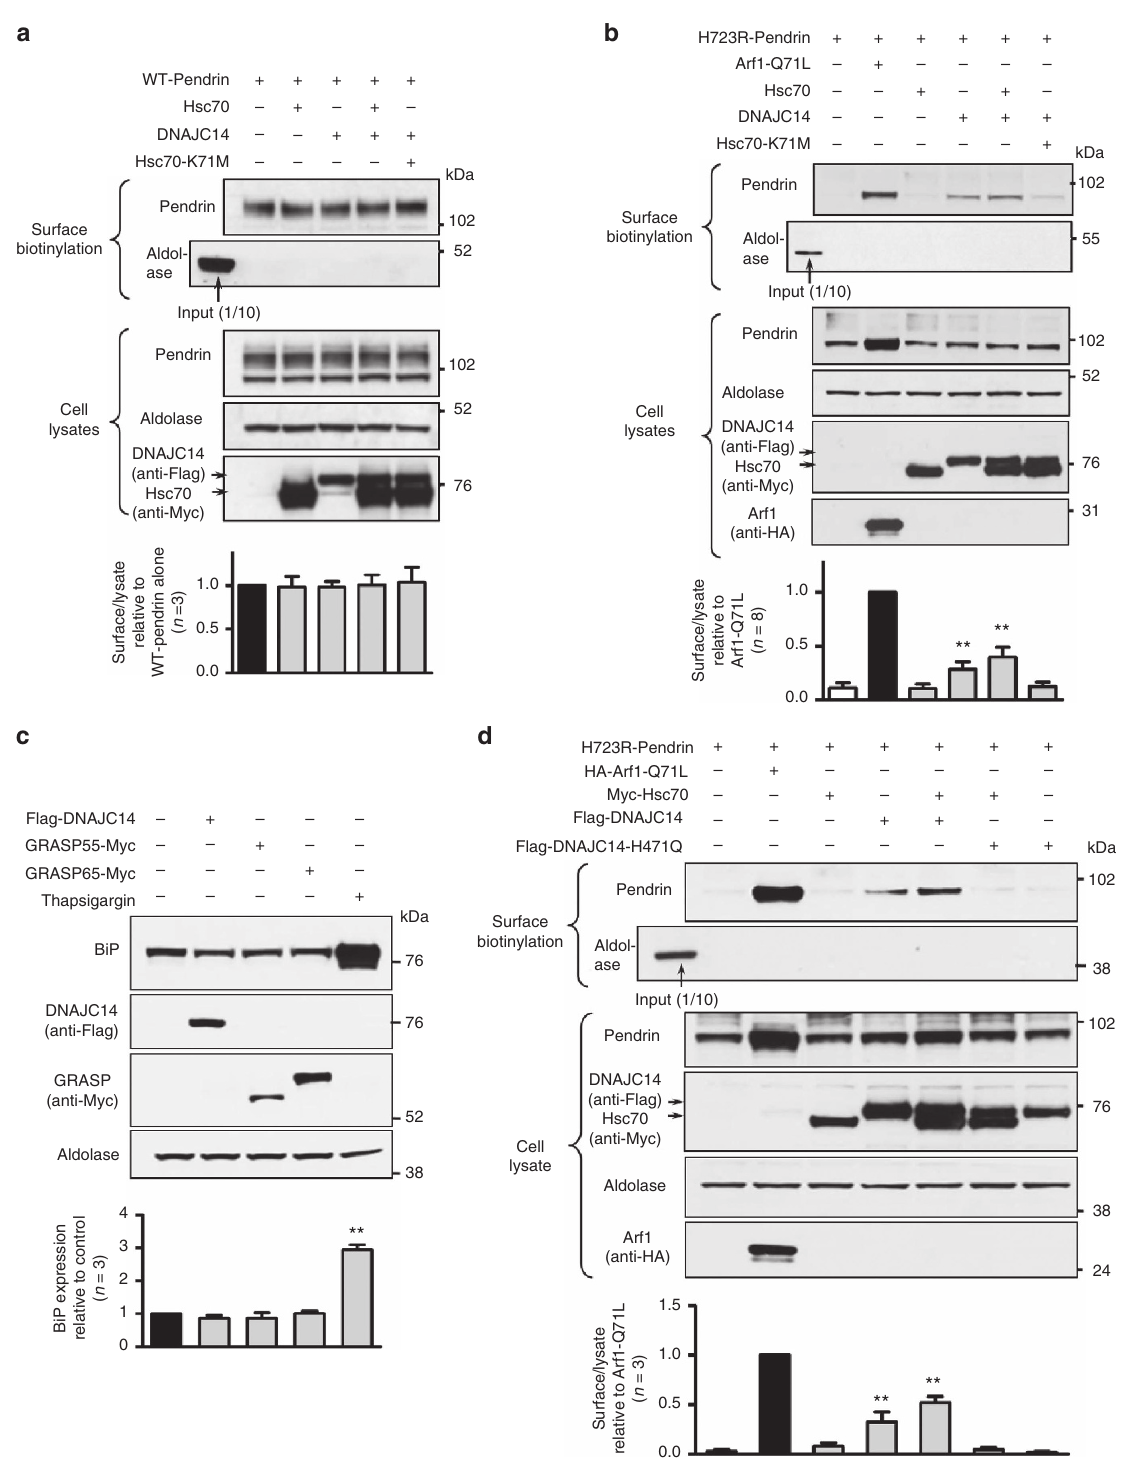
Figure 7 | DNAJC14 upregulation restores the cell-surface expression of H723R-pendrin. ( a ) The surface expression of WT-pendrin is not affected by upregulation of Hsc70 and DNAJC14 or by inhibition of Hsc70 ATPase activity (Hsc70-K71M) in PANC-1 cells. ( b ) Overexpression of DNAJC14 alone or with Hsc70 induces the cell-surface expression of core-glycosylated H723R-pendrin in PANC-1 cells. Note that K71M abolished the effect of DNAJC14 to rescue H723R-pendrin at the surface. ( c ) Expression of BiP was analysed as an indicator of ER stress. Cells treated with thapsigargin were used as a positive control. Overexpression of DNAJC14, GRASP55 or GRASP65 did not increase BiP in PANC-1 cells. ( d ) The DNAJC14-H471Q mutation, which results in the loss of the Hsc70 ATPase accelerating activity, abolished the ability of DNAJC14 to rescue H723R-pendrin at the surface. Quantitation of multiple experiments is presented under each immunoblot. ** P o 0.01 by one-way analysis of variance, difference from lane 1, the number of replicates ( n ) is presented in each panel. Unprocessed original scans of western blots are shown in Supplementary Fig.